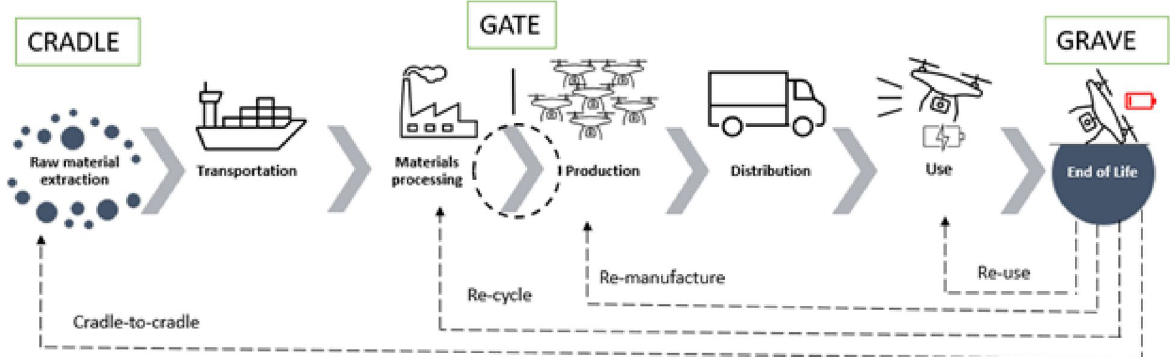
Fig. 2 Phases in LCA of a drone to measure impact from raw material extraction to EoL. LCA studies can be conducted from cradle-to-cradle, cradle-to-grave, cradle-to-gate, gate-to-gate, and gate-to-grave depending on the goal and scope of the